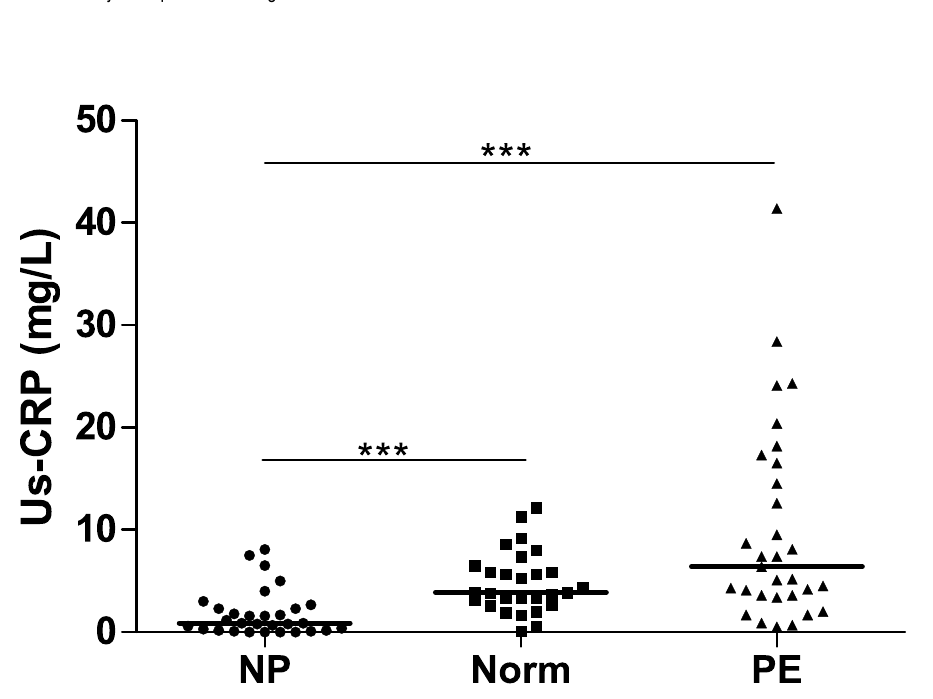
Fig 4. us-CRP plasma levels in non-pregnant, normotensive pregnant and PE women. NP (non- pregnant women), Norm (normotensive pregnant women), PE (preeclamptic women). Horizontal bars represent median values for us-CRP (milligrams/liter). *** P < 0.001. Plasma levels of us-CRP were higher in normotensive pregnant women compared to non-pregnant women and in PE women than in non-pregnant women. No significant difference was detected between PE and normotensive pregnant women.